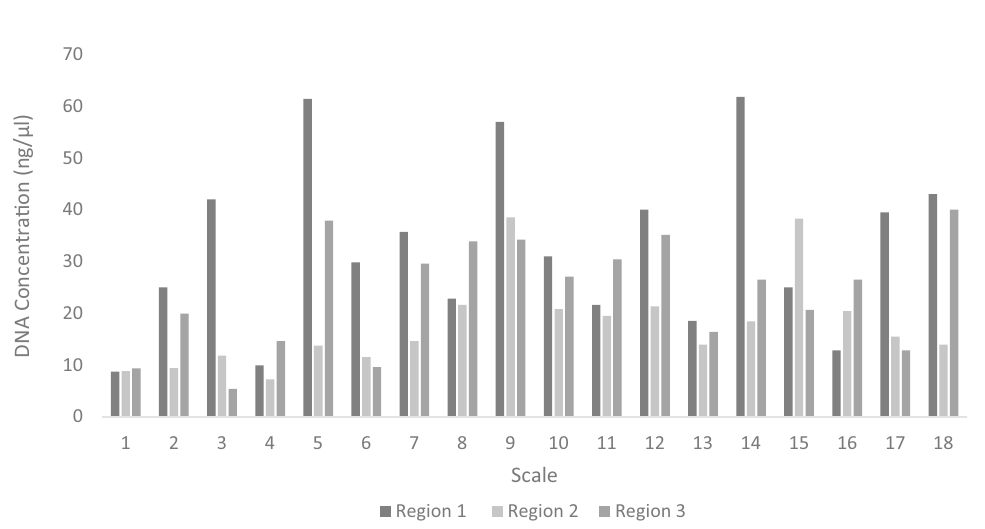
Figure 5. Bar graph indicating the concentration of extracted DNA from the three different scale regions. Extractions from scale 1–6, 7–12 and 13–18 were completed on three consecutive